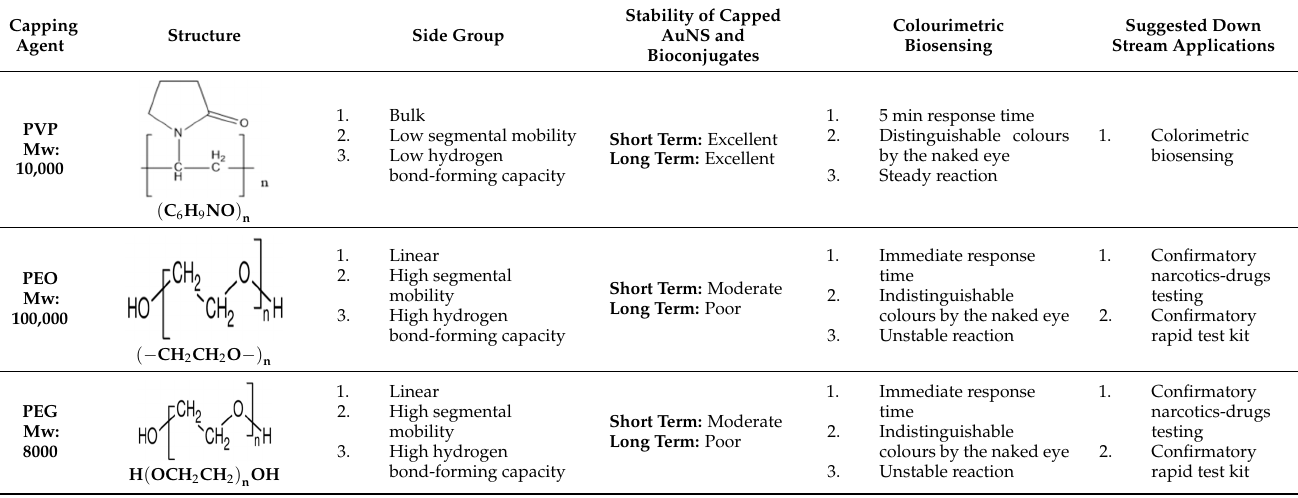
Figure 5. Glucose-sensing-efficacy-normalized UV-vis spectra and correlation curves: ( A , B ) AuNS- GOx; ( C , D ) AuNS-PVP-GOx; ( E , F ) AuNS-PEO-GOx; and ( G , H ) AuNS-PEG-GOx. Table 1. Summary of results: structure–function relationship.